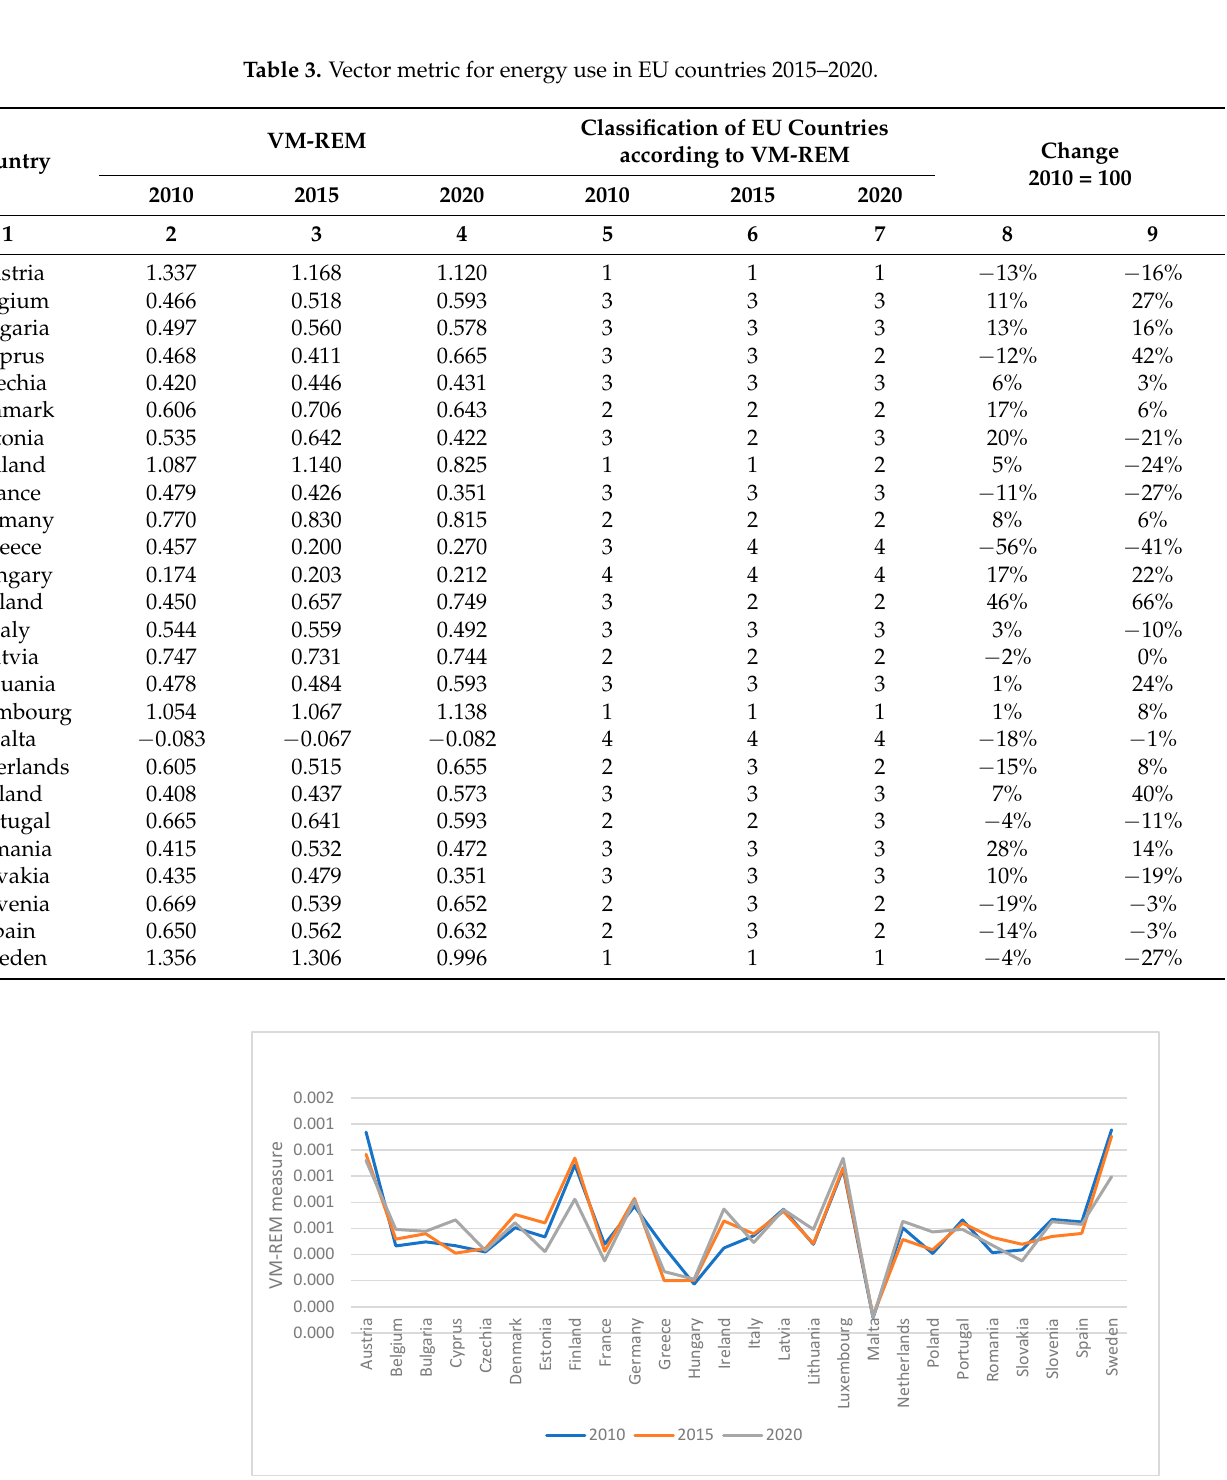
Figure 4. VM-REM for EU countries in 2010, 2015, and 2020. Table 3. Vector metric for energy use in EU countries 2015–2020.